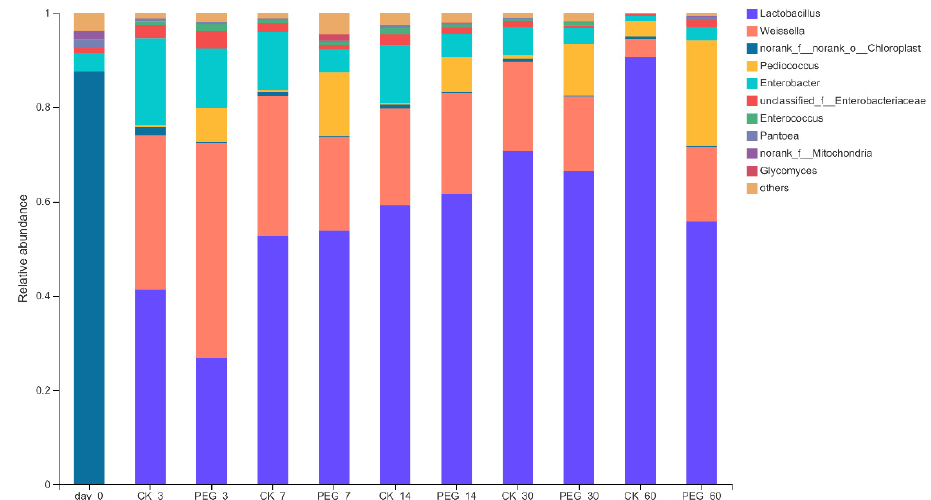
Figure 3. Relative abundance of bacterial community on the genus level of PEG-treated and control group of sainfoin silage (CK_3: on day 3 of control ensiling; PEG_3: on day 3 of PEG-treated ensiling, same as others).